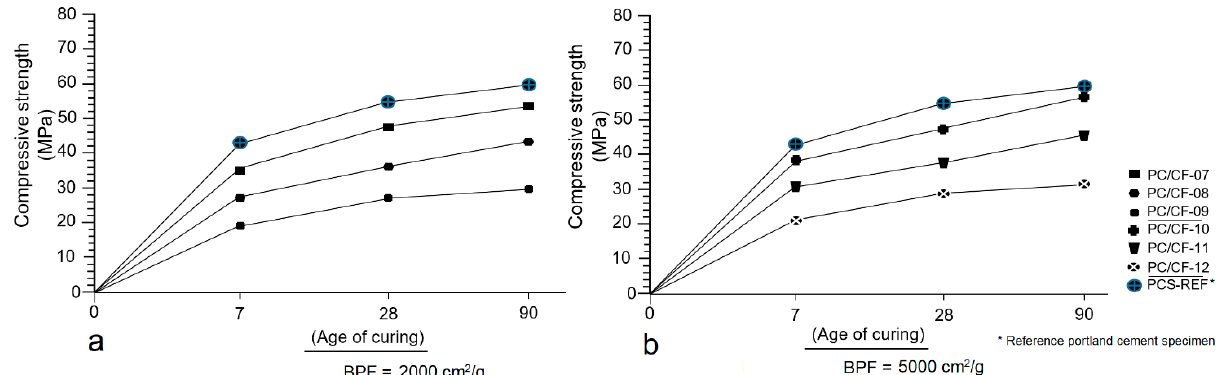
Figure 7. Mechanical strengths of specimens elaborated with replacement of PC by CF in 10, 25 and 40%. The BPF of CF in ( a ) is 2000 cm 2 /g, while in ( b ) it is 5000 cm 2 /g.